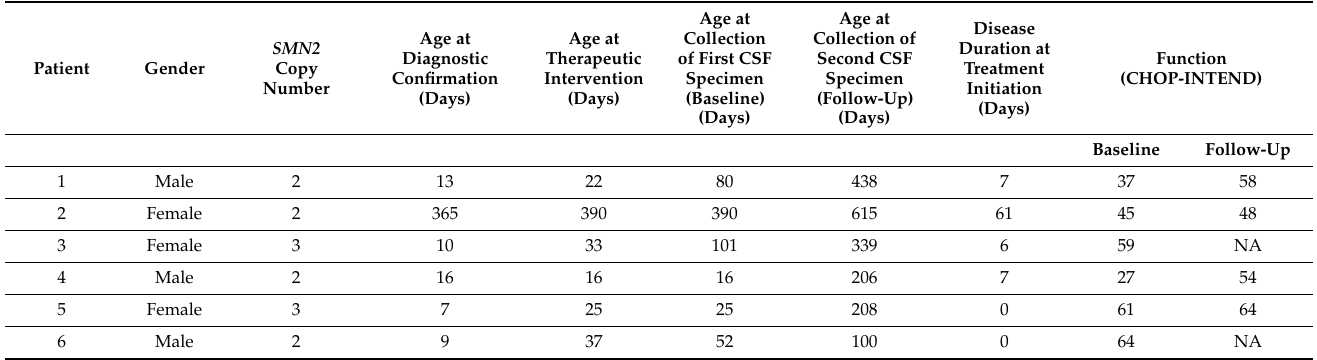
Table 1. Clinical characteristics of study participants undergoing nusinersen